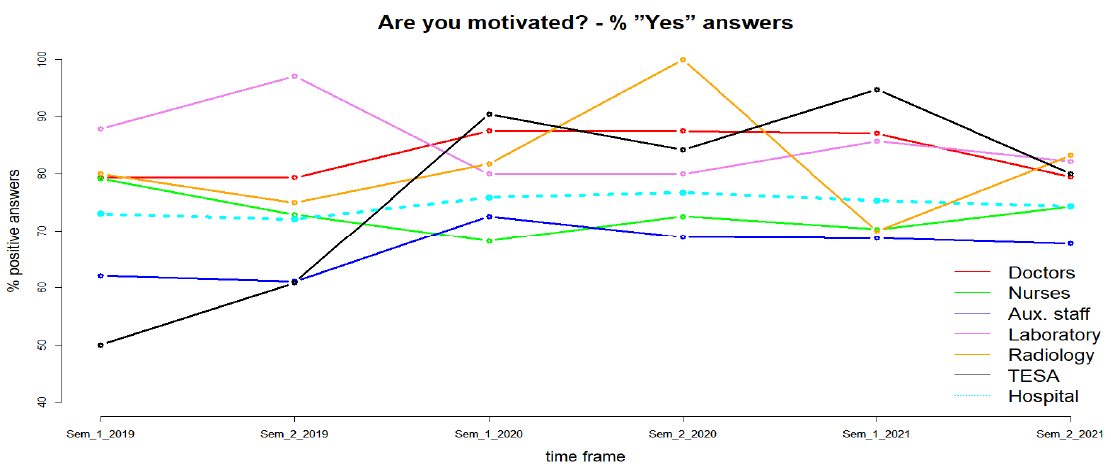
Figure 1. The evolution of the degree of motivation.